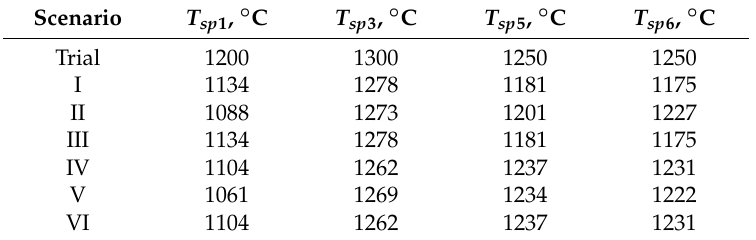
Table 3. Optimal furnace set-point temperatures of different optimisation scenarios.